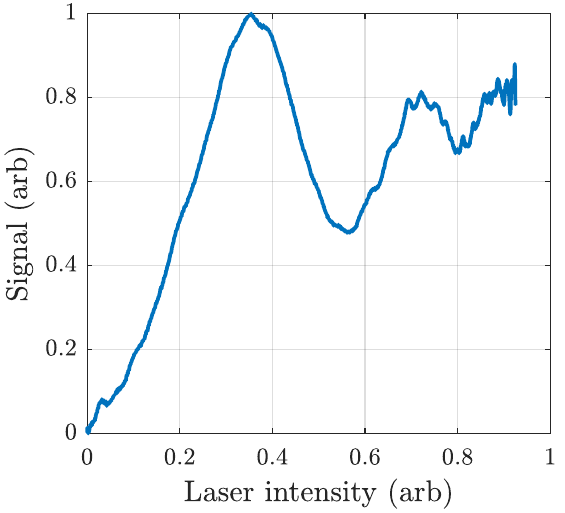
Figure 11. A typical measurement of Rabi oscillations as a function of laser intensity. The x-axis is scaled to the maximum power attainable and the y-axis is scaled to the maximum fluorescent